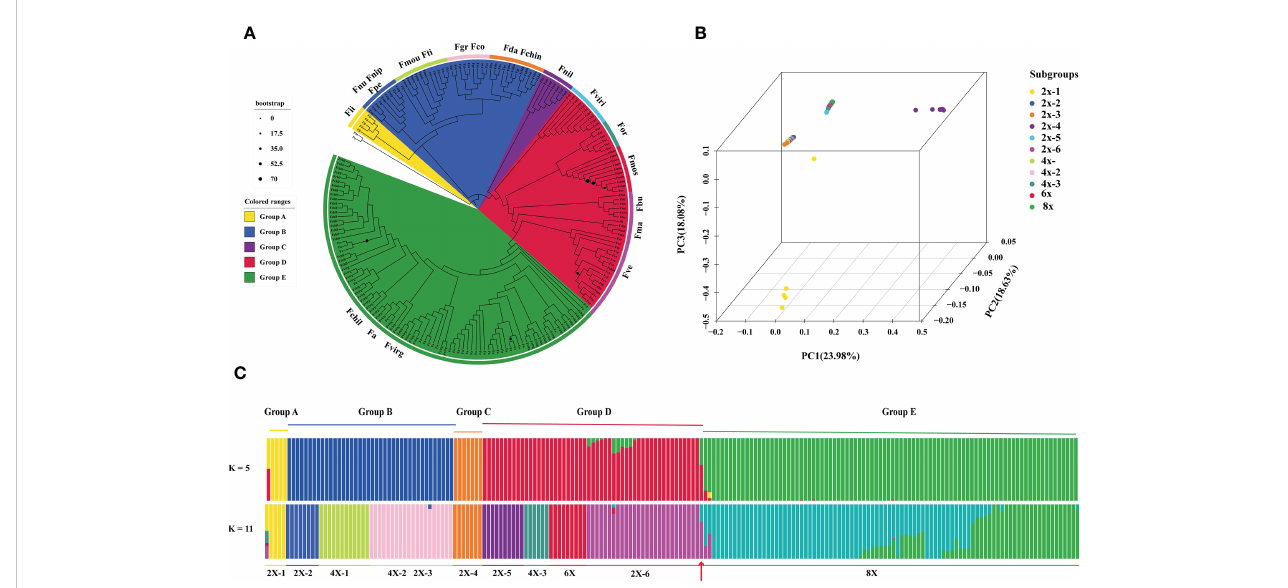
FIGURE 1 Analysis of Fragaria population genetic structure. (A) Phylogenetic tree based on sequence divergence of chloroplast genomes, with the colors of each branch region indicating the different groups (group A, B, C, D, E and outgroup). The colored circle outside the specie names represented the eleven subgroups: 2x-1, Fii, F iinumae ; 2x-2, Fnu, F nubicola , Fnip, F nipponica , Fpe, F pentaphylla ; 2x-3, Fda, F daltoniana , Fchin, F chinensis ;2x-4, Fnil, F nilgerrensis ; 2x-5, Fviri, F viridis ; 2x-6, Fbu, F bringhurstii ; Fma, F mandschurica ; Fve, F vesca ; 4x-1, Fmou, F moupinensis ; Fti, F tibetica ; 4x-2, Fgr, F gracilis ; Fco, F corymbosa ; 4x-3, F orientalis ; 6x, Fmos, F moschata ;8x, Fvirg, F virginiana ; Fchil, F chiloensis ; Fa, F .x ananassa . The blue circle sizes are shown as the percentage of bootstrap support less than 70%; (B) Principal component analysis (PCA) plot of the 198 Fragaria accessions, PC1, PC2 and PC3 explained 23.98%, 18.64% and 18.08% proportion of variance; (C) Population strati fi cation analyses of Fragaria species. ADMIXTURE plots for representative Fragaria accessions and the outgroup for K=5 and K= 11. The order of Fragaria species was in line with the phylogenetic tree. The red arrow indicates the diploid F vesca subsp.